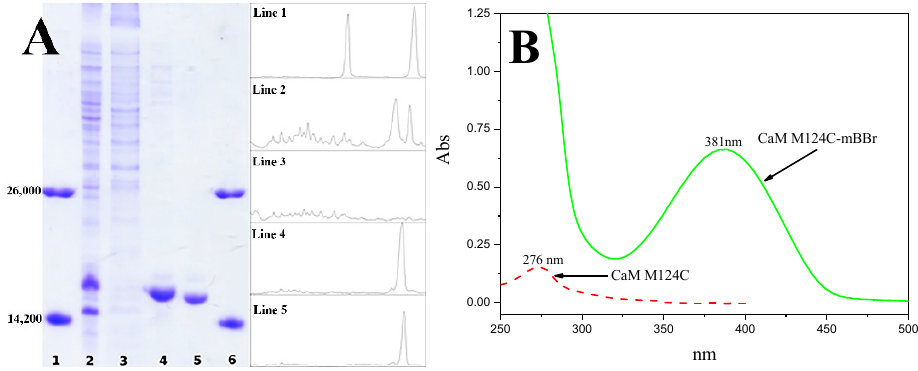
Figure 3. ( A ) Follow-up of the purification of the h CaM M124C protein by SDS-PAGE. Lane 1 and 6 a-Lactoalbumin (14,200 Da) and LAO protein (26,000 Da), lane 2 supernatant after sonication, lane 3 fraction without binding to the Phenyl-Sepharose CL-4B column, lane 4 fraction corresponding to the h CaM M124C from the Phenyl-Sepharose CL-4B column and lane 5 fraction of the h CaM M124C- mBBr after passing through the size exclusion column (Superdex75). ( B ) The absorption spectra of the h CaM M124C ( ) and h CaM M124C- mBBr ( ).